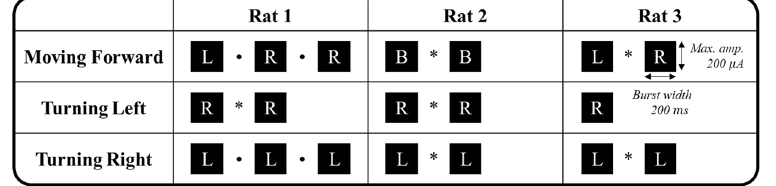
Figure 4. Individualized stimulation patterns for each command for each rat. Black squares represent a single electrical stimulation. The stimulation could be applied to the left (L), right (R), or both (B) NS pathways. The time between stimulations was either 200 ms (represented by a dot) or 300 ms (represented by an asterisk). All stimulation patterns were designed to be shorter than the inter-command interval of 500 ms. To compensate for response differences that depended on the rat’s condition, the stimulation amplitude ( ≤ 200 μ A) was selected before each experiment.